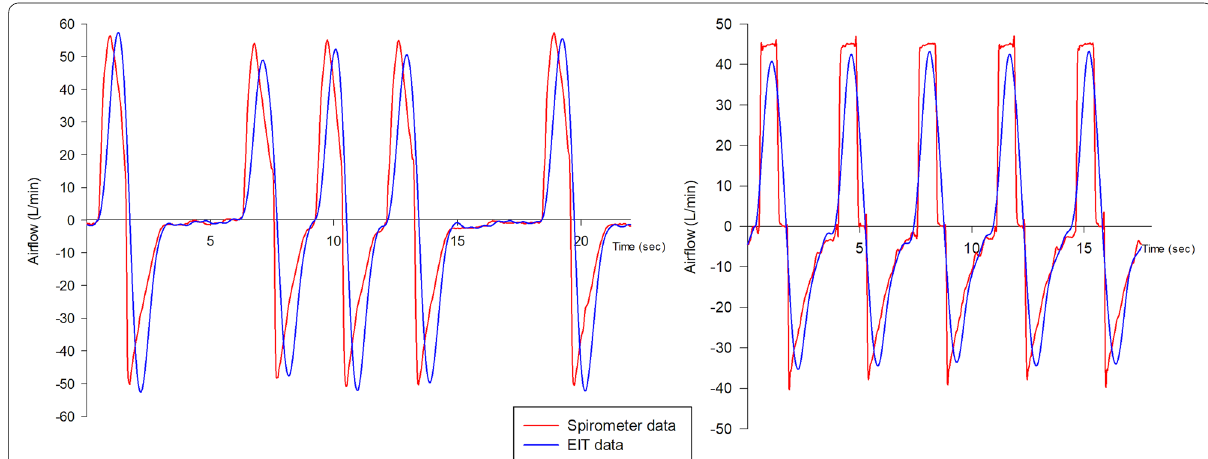
Fig. 1 Airflow waveforms measured by spirometer (red line) and electrical impedance tomography (EIT) (blue line) in two representative patients during pressure support ventilation (left) and volume‑controlled ventilation (right). Note the correspondence between peak values by the two methods, with only modest underestimation by